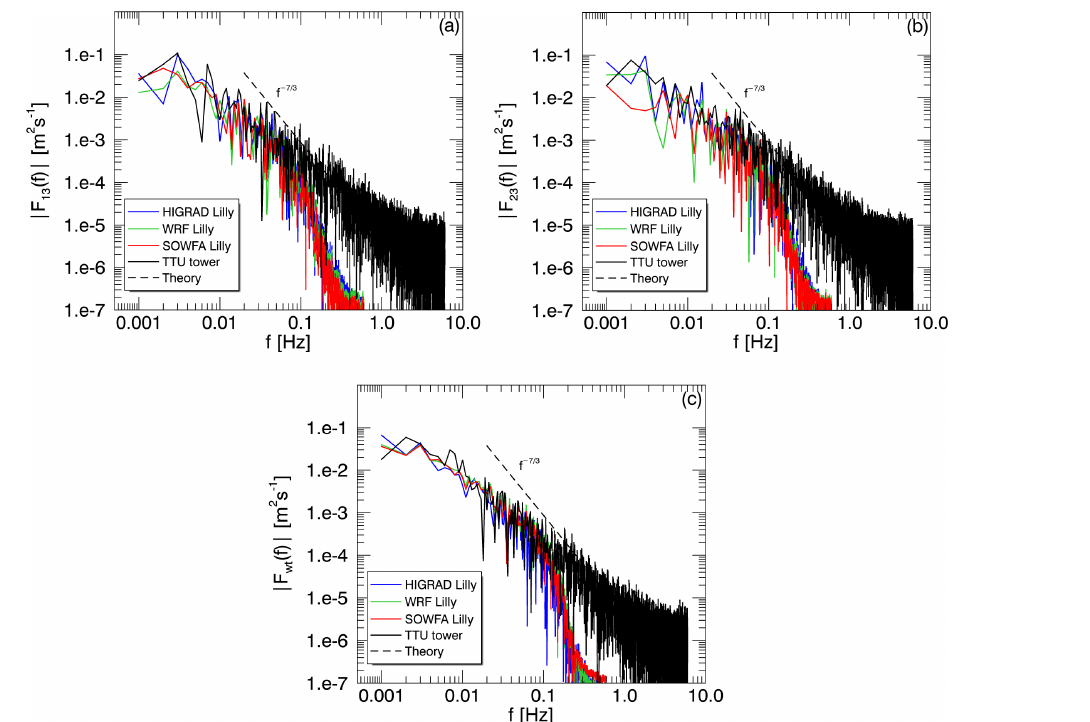
Figure 18. Simulated and measured cospectra of vertical and streamwise velocity (a) , vertical and spanwise velocity (b) , and measured vertical velocity and virtual potential temperature versus simulated vertical velocity and potential temperature (c) from the convective case